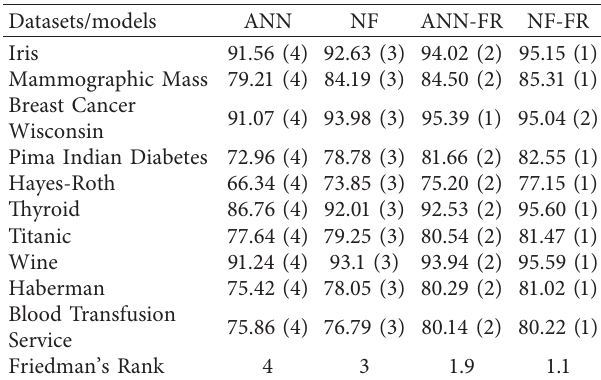
Table 4: Friedman’s rank to all the models based on avg. classi- fication